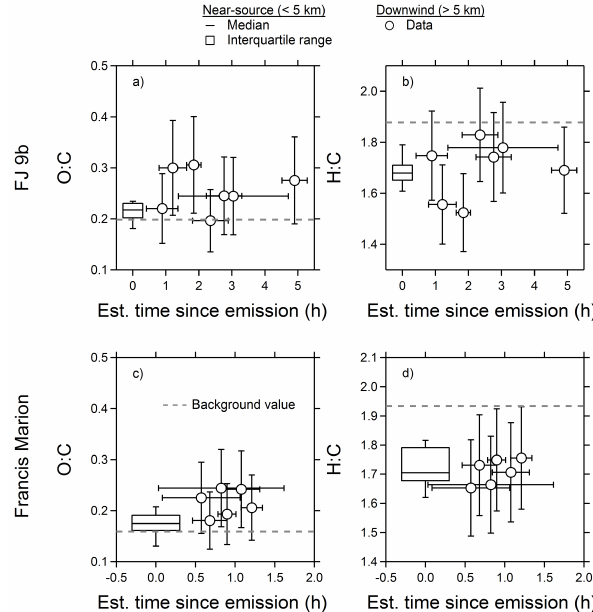
Figure 4. Evolution of background-corrected AMS mass fractions. (a) (cid:49)f 60 for the FJ 9b fire; (b) (cid:49)f 44 for the FJ 9b fire; (c) (cid:49)f 60 for the Francis Marion fire; (d) (cid:49)f 44 for the Francis Marion fire. In all panels, there is a statistically significant difference between data collected near the source and downwind. Box-and-whisker plots and markers are used in the same way as those in Figs. 2 and 3.